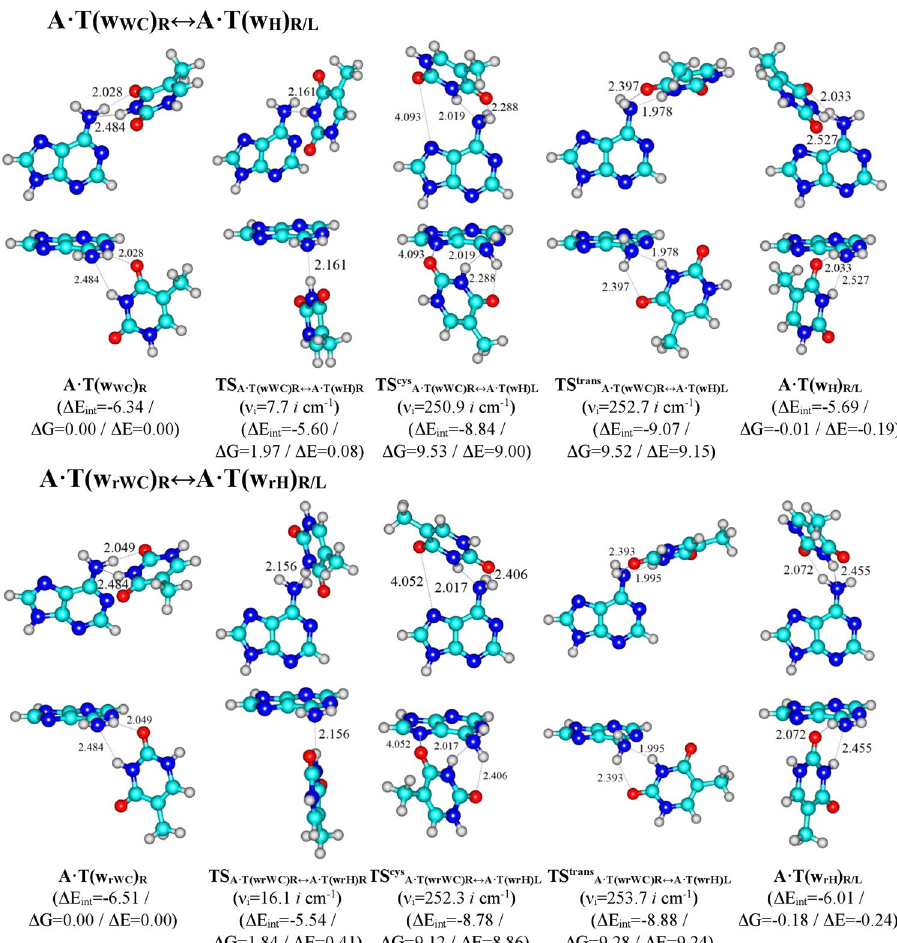
Figure 1. Geometrical structures of the stationary points on the reaction pathways of the discovered conformational transitions of the four biologically important А·Т DNA bps. Electronic energies of the interaction Δ E int (MP2/6-311 ++ G(2df,pd)//B3LYP/6-311 ++ G(d,p) level of theory, in kcal∙mol − 1 ), relative Gibbs free energies ∆ G and electronic energies ∆ E (in kcal∙mol − 1 ), imaginary frequencies ν i at the TSs of the conformational transitions (MP2/aug-cc-pVDZ//B3LYP/6-311 ++ G(d,p) level of theory in the continuum with ε = 4 at T = 298.15 К) are presented below complexes in brackets. Dotted lines indicate AH···B H-bonds and attractive A···B van der Waals contacts – their lengths are presented in angstroms (for their more detailed physico-chemical characteristics see Table 2); carbon atoms are in light-blue, nitrogen – in dark-blue, hydrogen – in grey and oxygen – in red. Exclusively enantiomers of one type are presented.